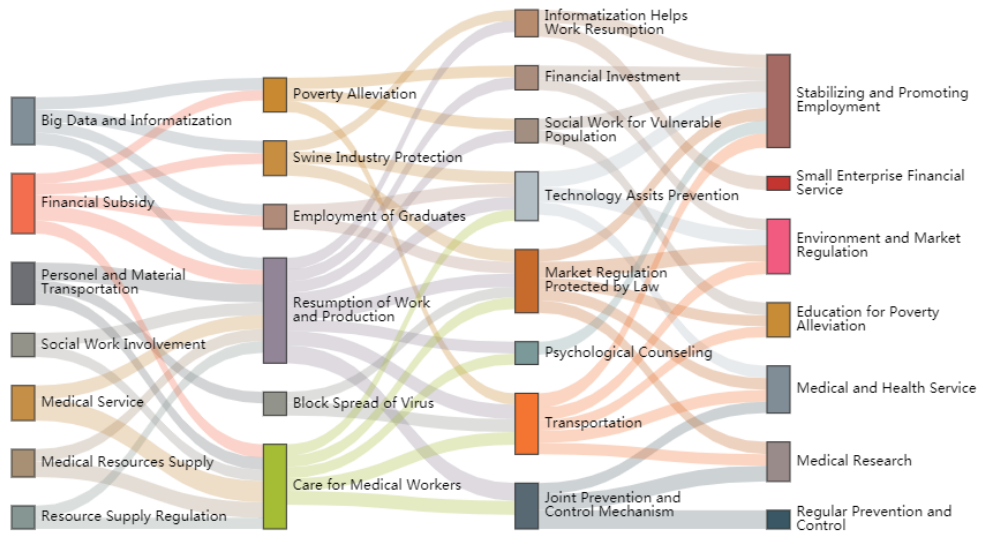
Figure 8. The topic evolution path of managing COVID-19 in China.